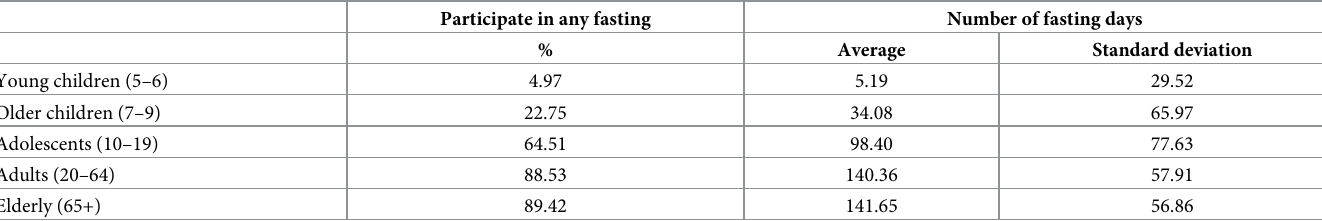
Table 5. Participation rates and fasting days per age group for members of the Orthodox